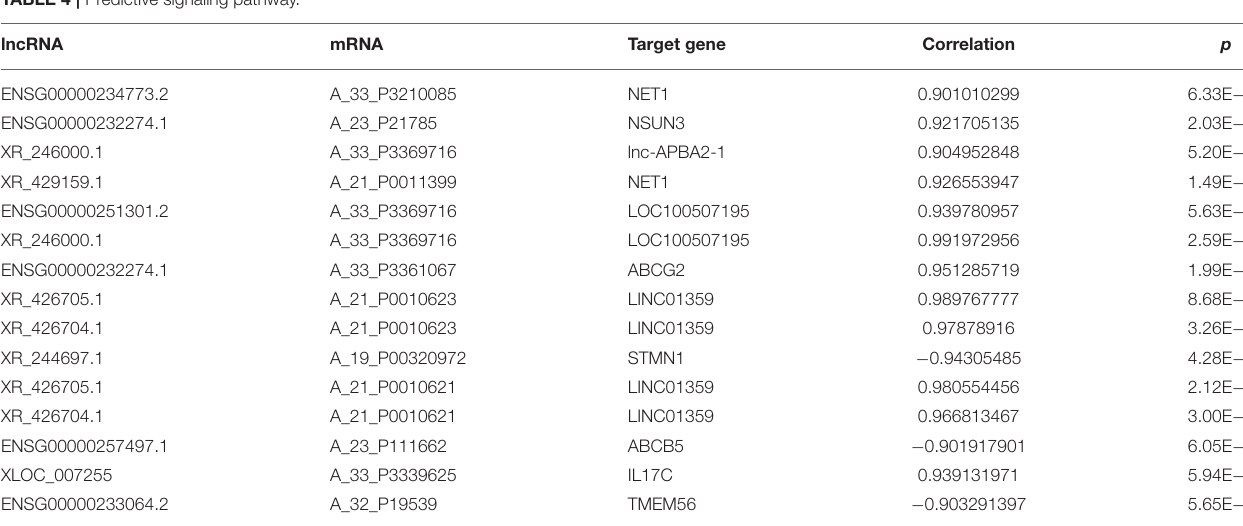
TABLE 4 | Predictive signaling pathway. lncRNA mRNA Target